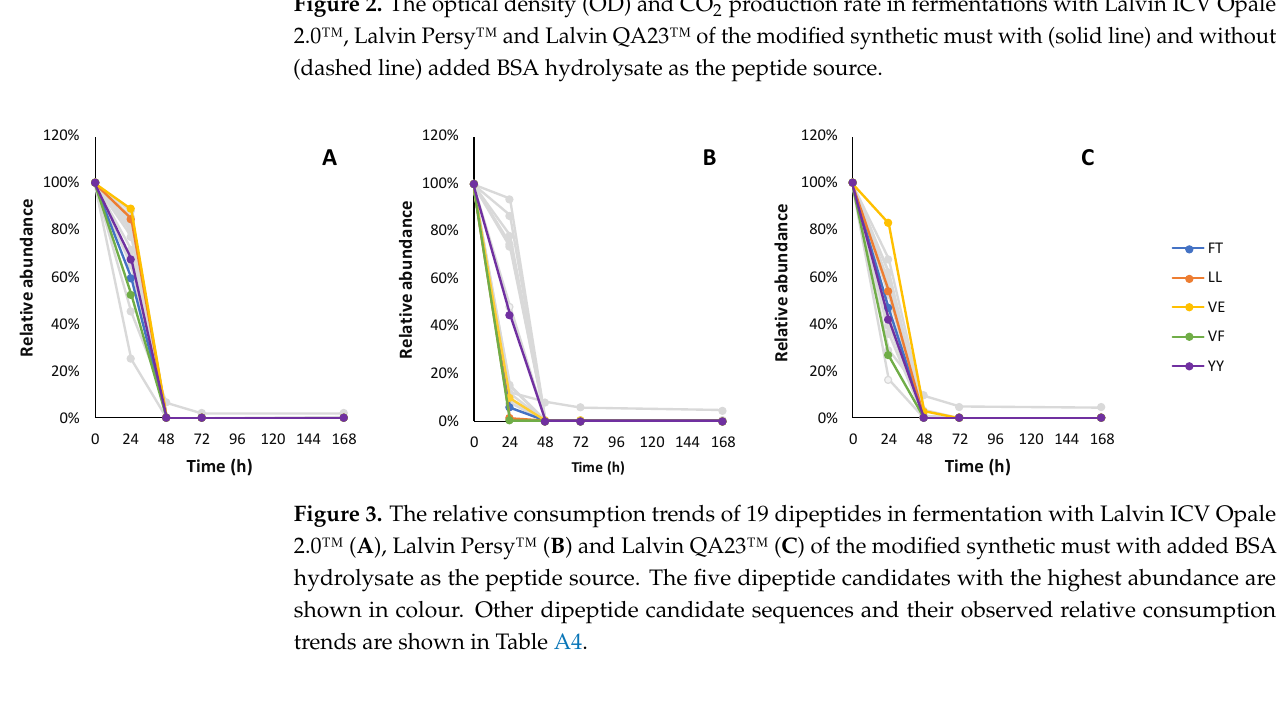
Figure 4. The relative consumption trends of 41 tripeptides in fermentation with Lalvin ICV Opale 2.0™ ( A ), Lalvin Persy™ ( B ) and Lalvin QA23™ ( C ) of the modified synthetic must with added BSA hydrolysate as the peptide source. The five tripeptide candidates with the highest abundance are shown in colour. Other tripeptide candidate sequences and their observed relative consumption trends are shown in Table A5. Figure 5. The relative consumption trends of 31 tetrapeptides in fermentation with Lalvin ICV Opale 2.0™ ( A ), Lalvin Persy™ ( B ) and Lalvin QA23™ ( C ) of the modified synthetic must with added BSA hydrolysate as the peptide source. The five tetrapeptide candidates with the highest abundance are shown in colour. Other tetrapeptide candidate sequences and their observed relative consumption trends are shown in Table A6.